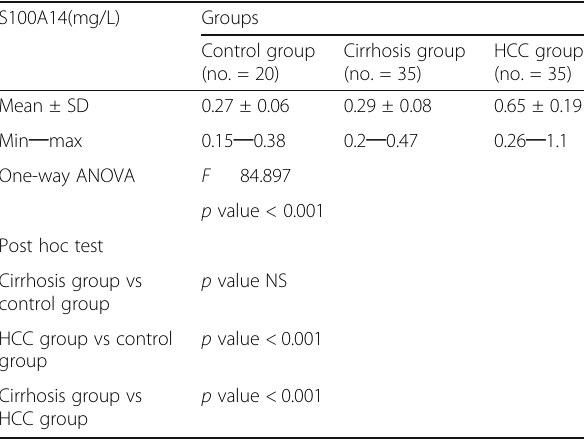
Table 2 VaL) in all studied group/L) in all studied groups Table 3 Values of AFP in all studied